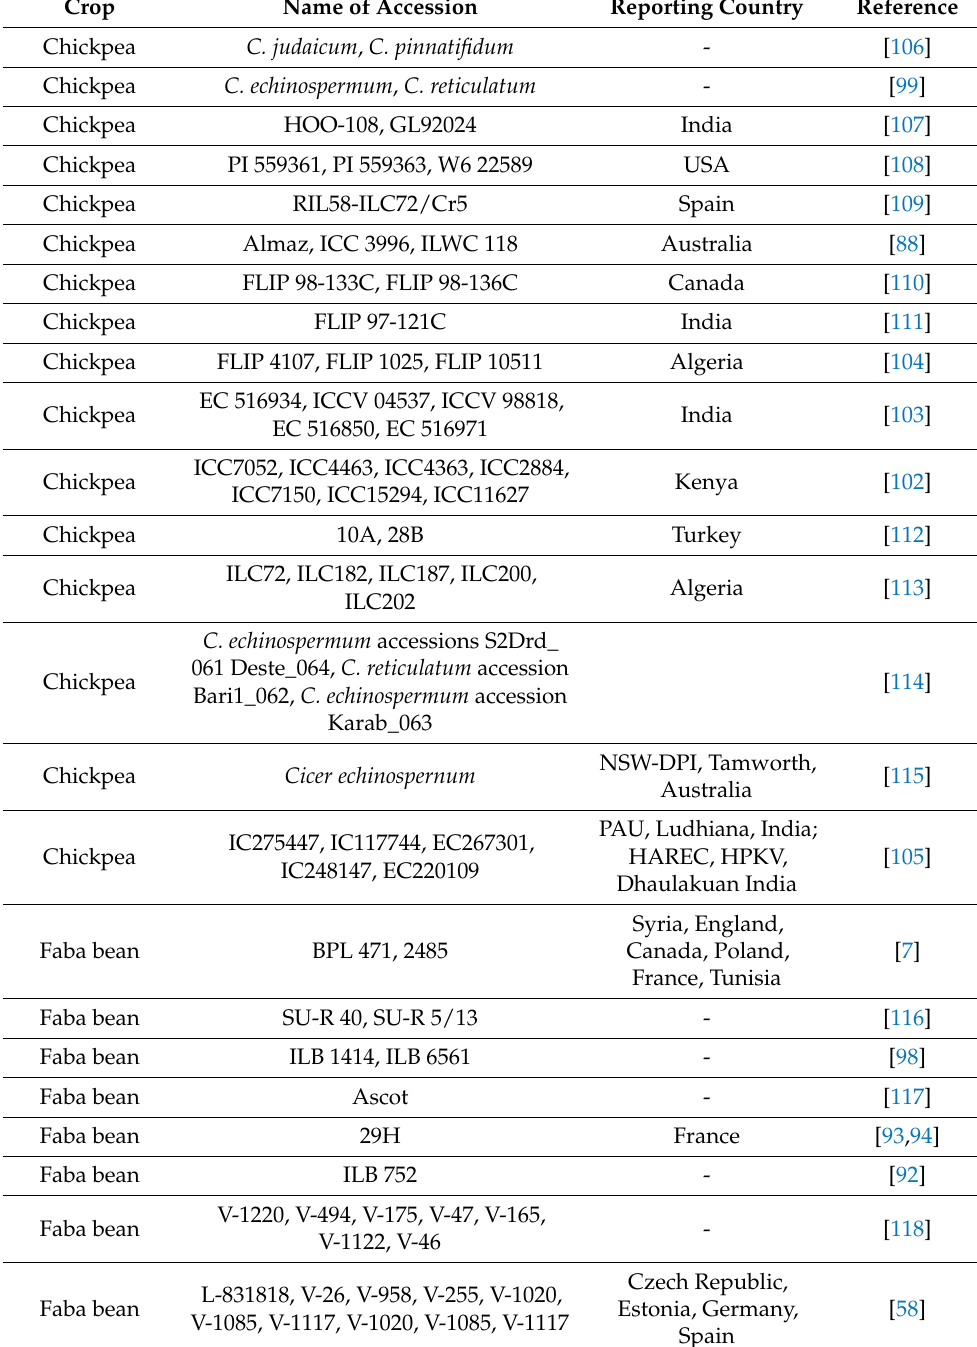
Table 2. Sources of Ascochyta blight resistance in various grain